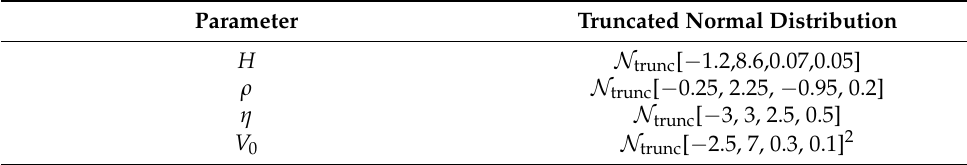
Figure 5. The Heston model’s IV surface inverted from S&P options data by FCNN. Table 5. Parameter